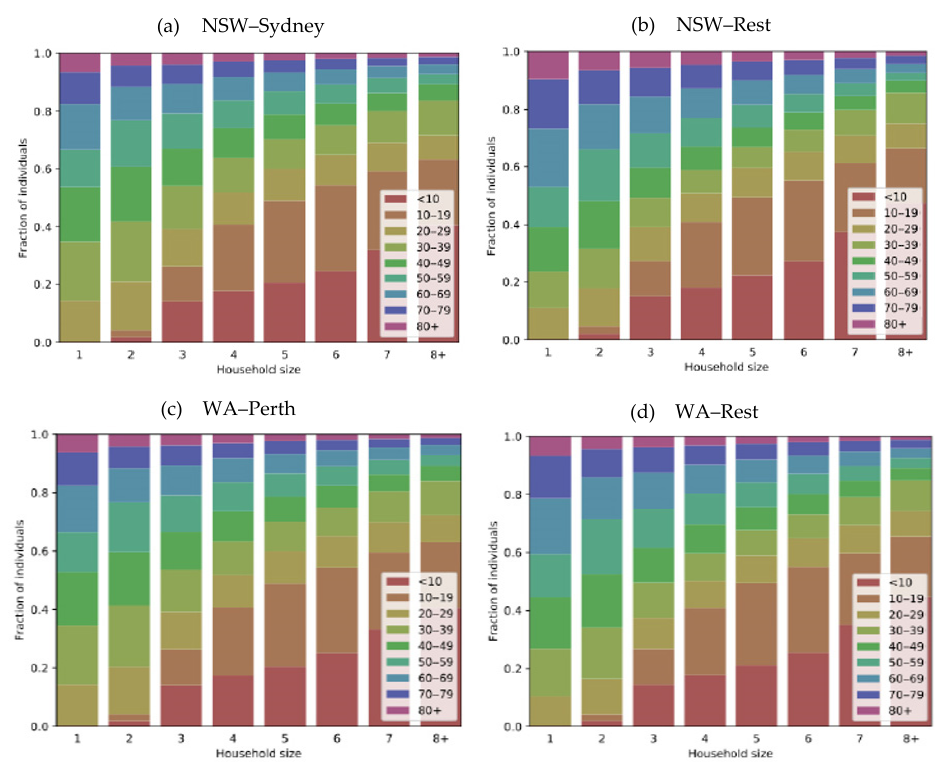
Figure 3. Summaries of age profiles and household sizes in two states: ( a ) age; and ( b ) household size, according to Census 2016 (Australian Bureau of Statistics 2016).